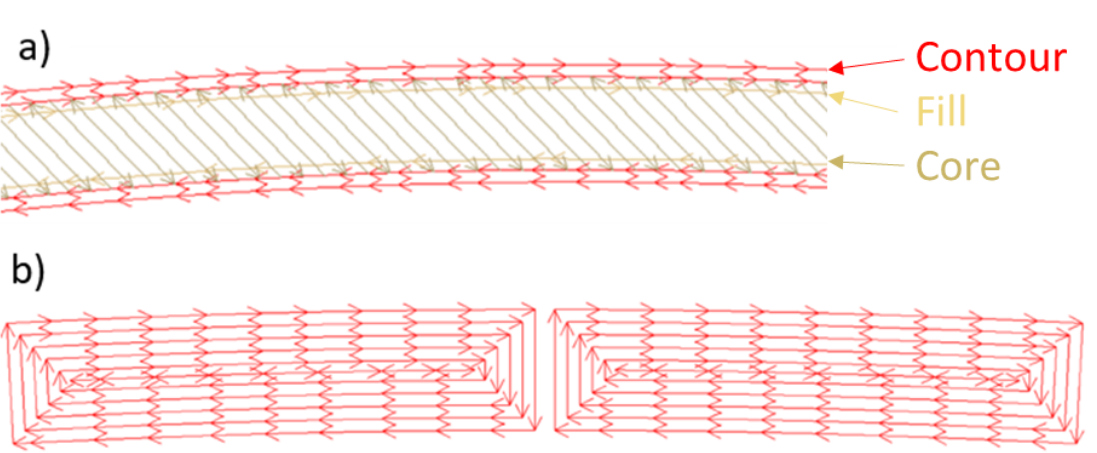
Figure 1. Magnified views of ring section to illustrate different irradiation strategies for laser scan paths: ( a ) stripes ( b )